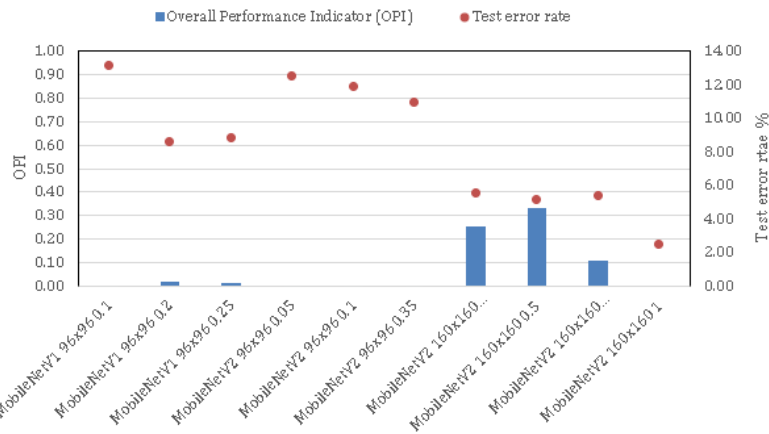
Figure 9. Overall performance indicators for the tested MobileNet